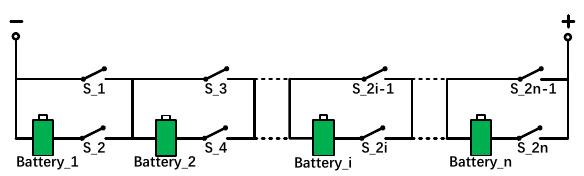
Figure 1. Reconfigurable equalization topology.